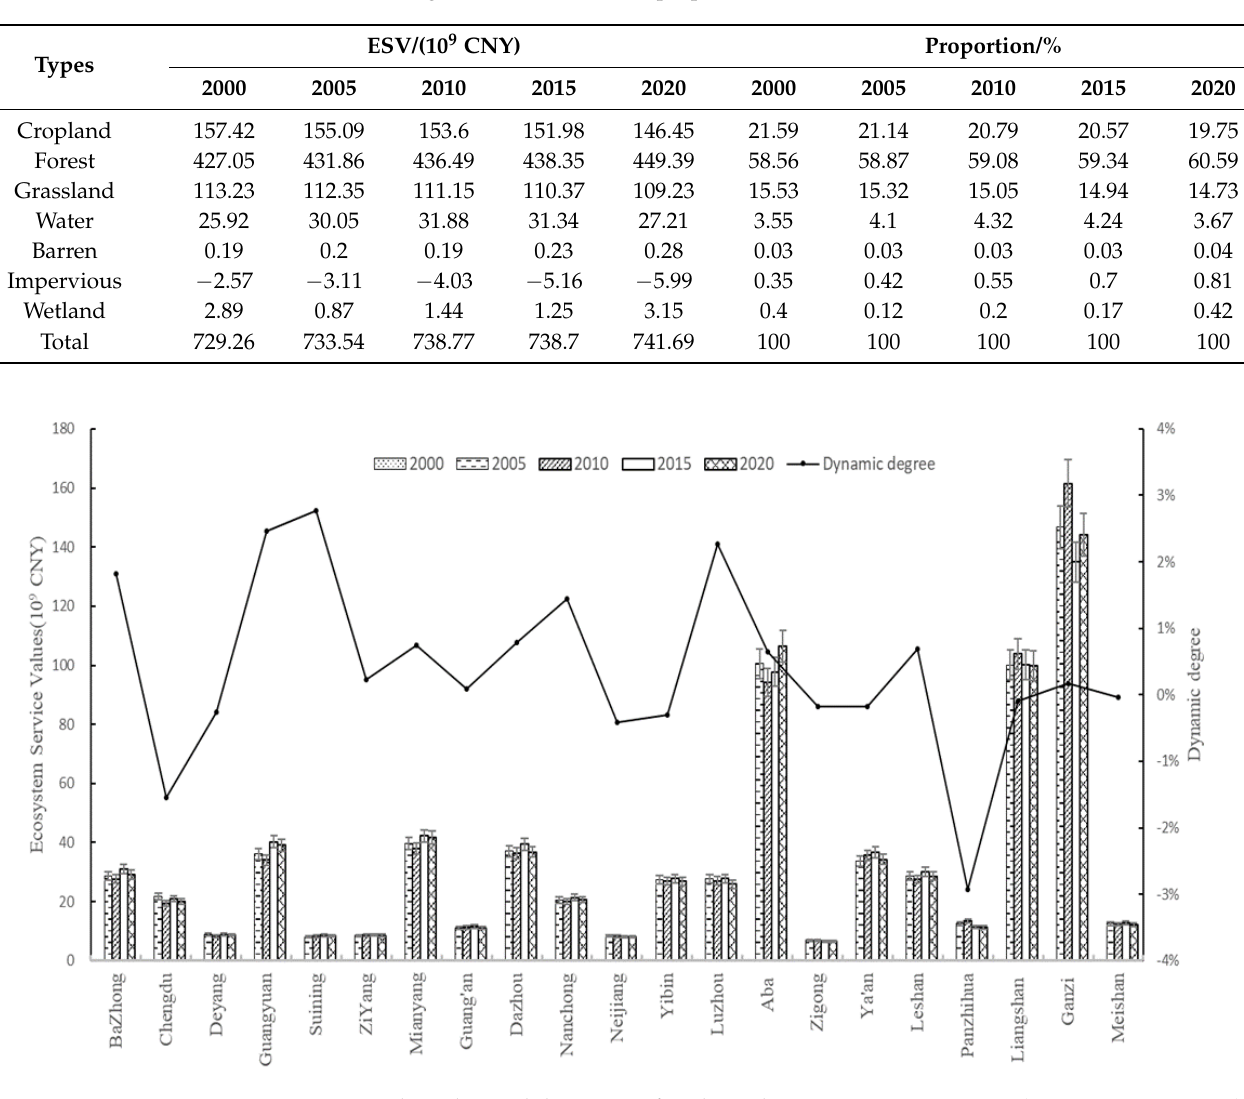
Table 4. Ecological service value and proportion of land use in Sichuan Province from 2000 to 2020.